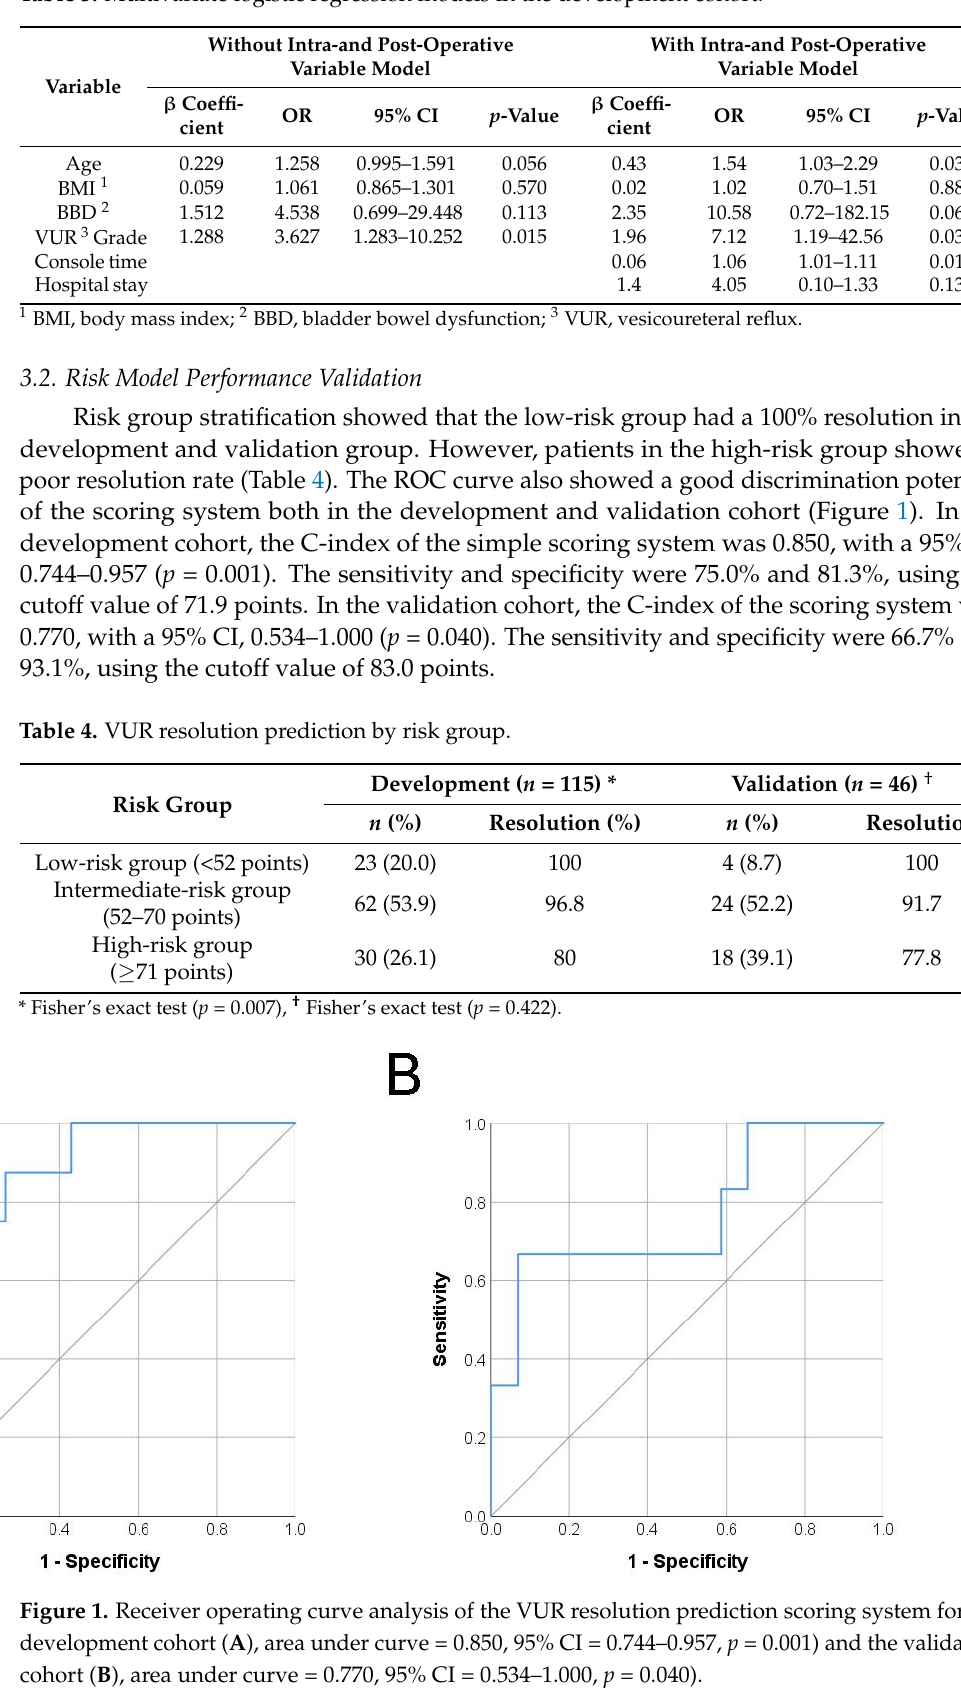
Table 3. Multivariate logistic regression models in the development cohort.